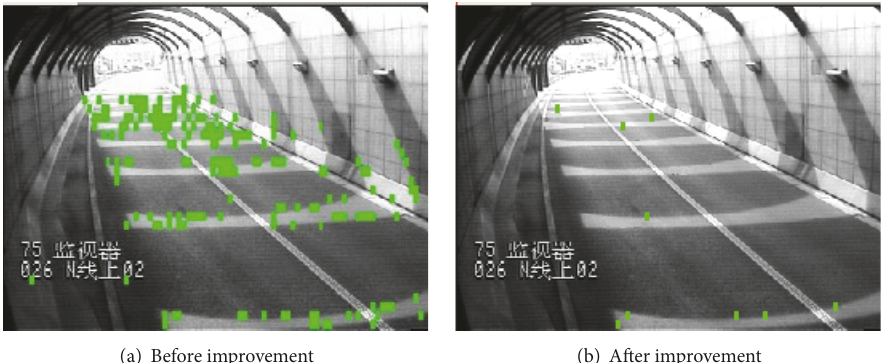
Figure 19: Comparison of the effects before and after the improvement of the algorithm for the exit of Shanghai Fuxing Road Tunnel.